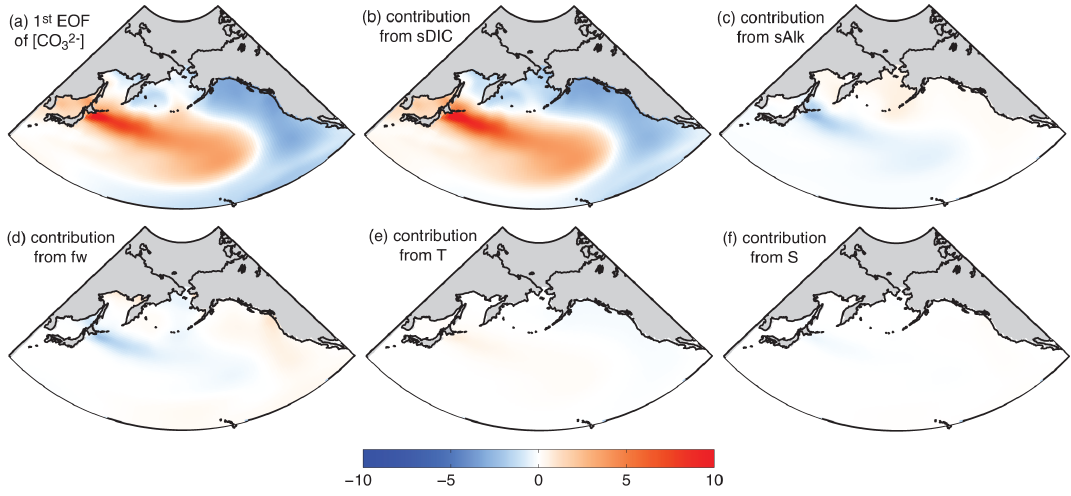
Figure 9. As in Fig. 7, but for the North